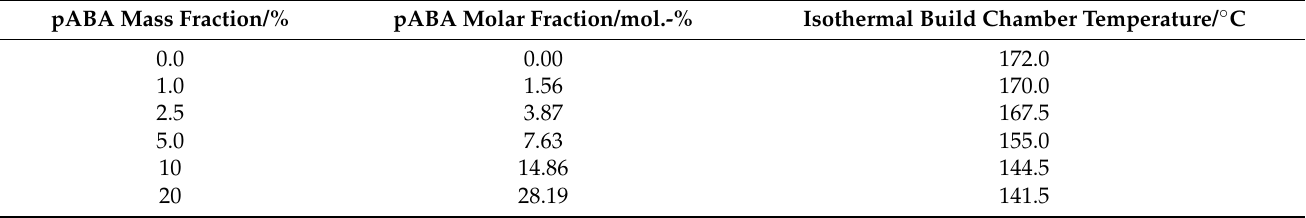
Table 1. Overview of applied mass fractions, corresponding molar fractions of pABA, and applied material-specific isothermal build chamber